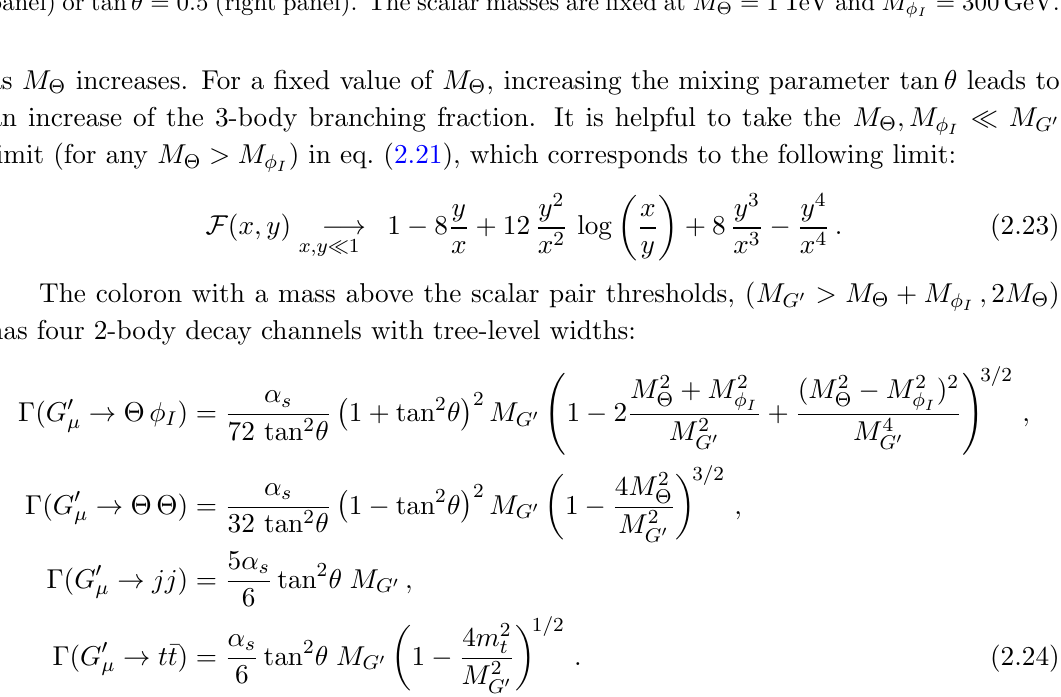
0 , as a function of its mass, for tan (cid:18) = 0 : 2 (left = 300 I